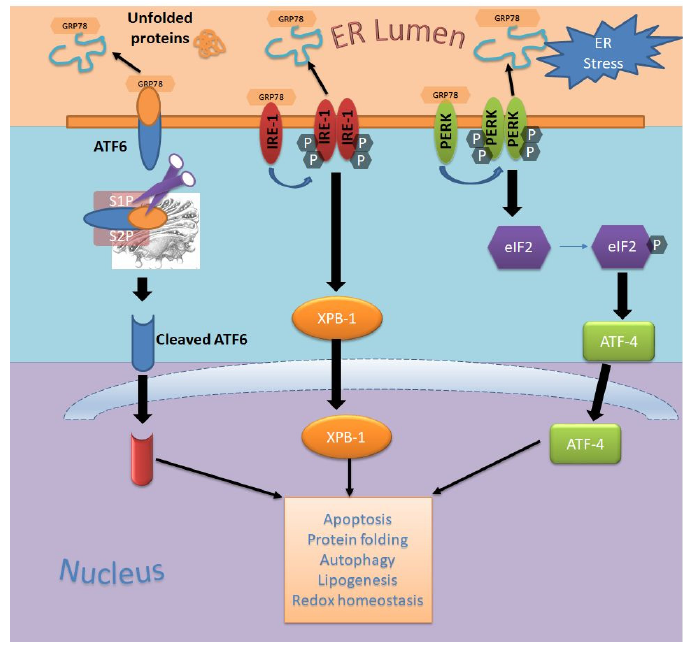
Figure 1. Endoplasmic reticulum stress mediated cell signaling pathway.